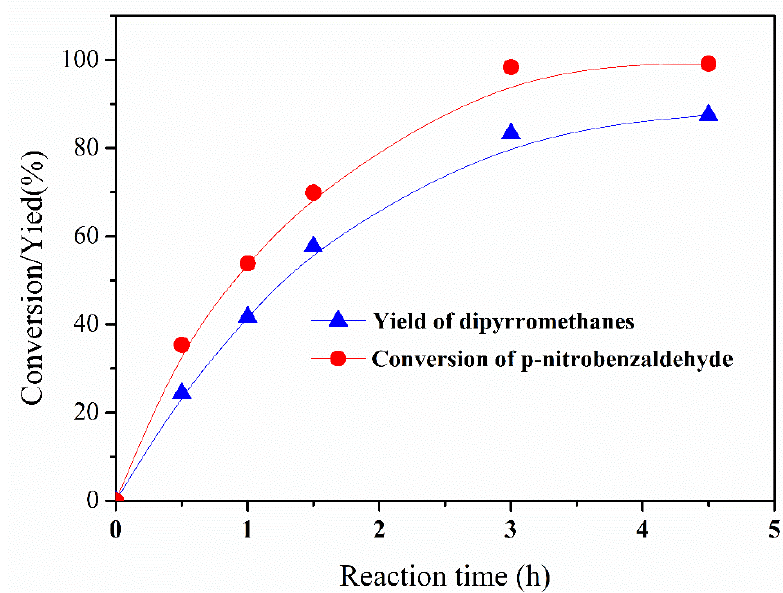
Figure 13. Conversion of p-nitrobenzaldehyde and the yield of 2,2′-(4-nitrophenyl) dipyrromethane in the batch reactor at various reaction times.